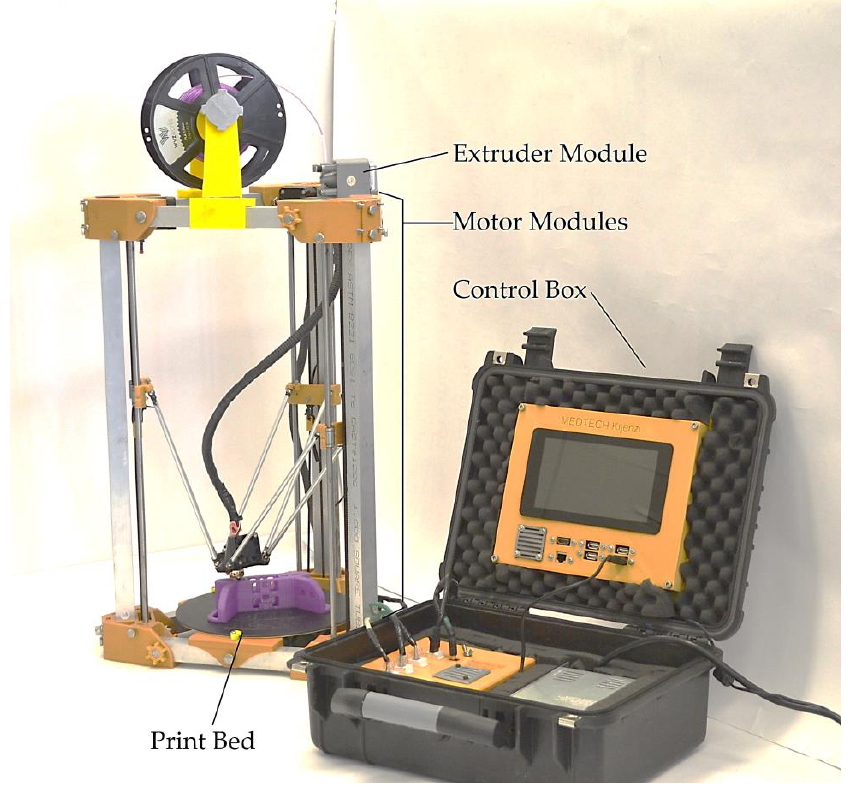
Figure 2. The Kijenzi 3-D printer prototype assembled and configured for operation.